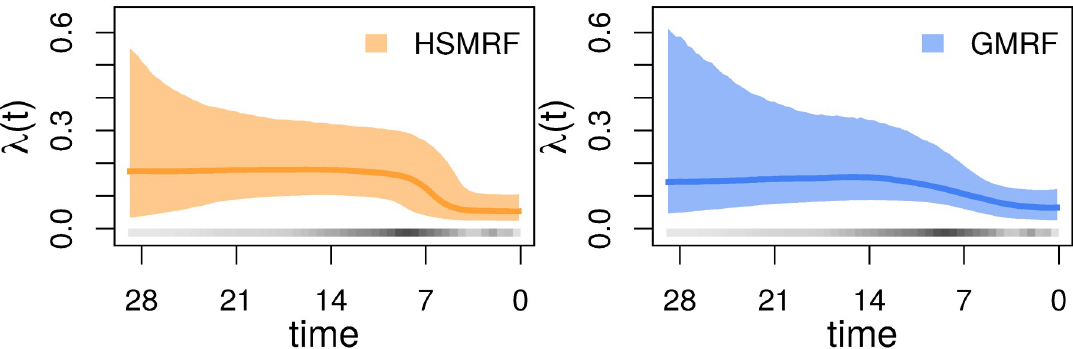
Fig 7. Analyses of the Pygopodidae dataset. Plotted are posterior median trajectories (dark lines) and 90% credible intervals (shaded regions). Time is in millions of years before the present day. In grey is a heatmap of the inferred divergence